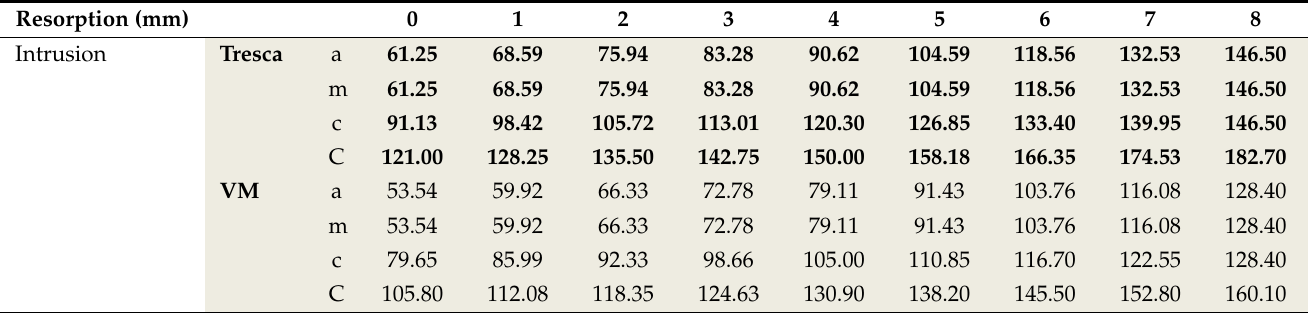
Figure 7. Comparative stress display of the five failure criteria in intact, 4 mm and 8 mm periodontal breakdown for the translation movement under 0.5 N of load: ( A ) Tresca; ( B ) Von Mises; ( C ) Pressure; ( D ) S1; ( E ) S3. Table 2. Maximum stress average values (KPa) produced by 0.5 N/50 g of orthodontic forces in the tooth structure.